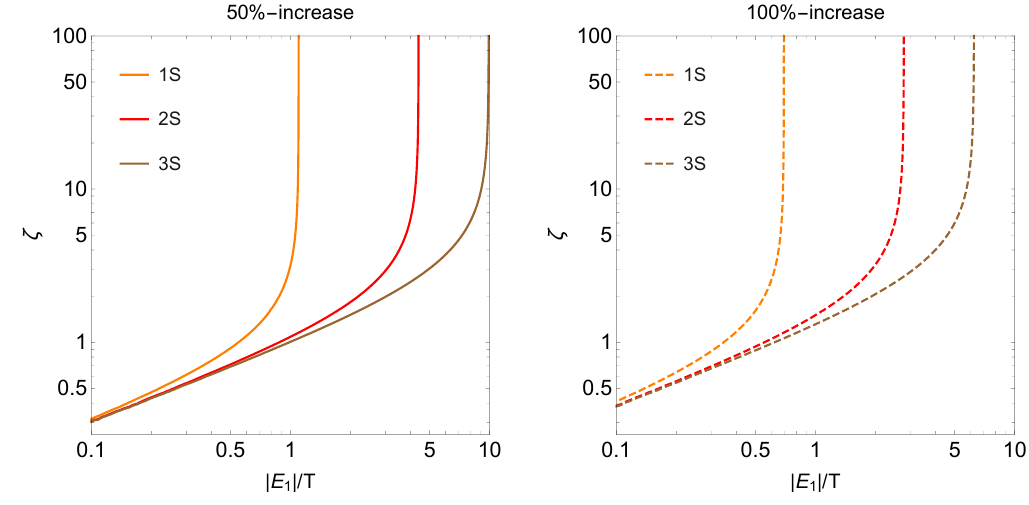
Figure 3 . Contour levels for the ratio of the thermal and in-vacuum cross sections 1+ n B (∆ E p the ( | E 1 | /T, ζ ) -plane. The solid (dashed) lines stand for a 50% (100%) increase of the in-vacuum cross section due to the Bose